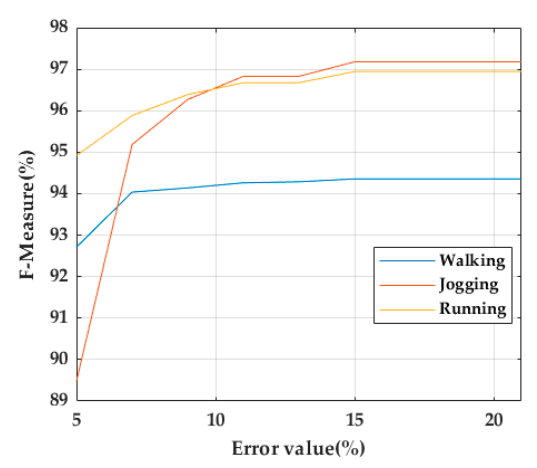
Figure 10. TO performance evaluation using error ranges from 5% to 21% in steps of 3%.